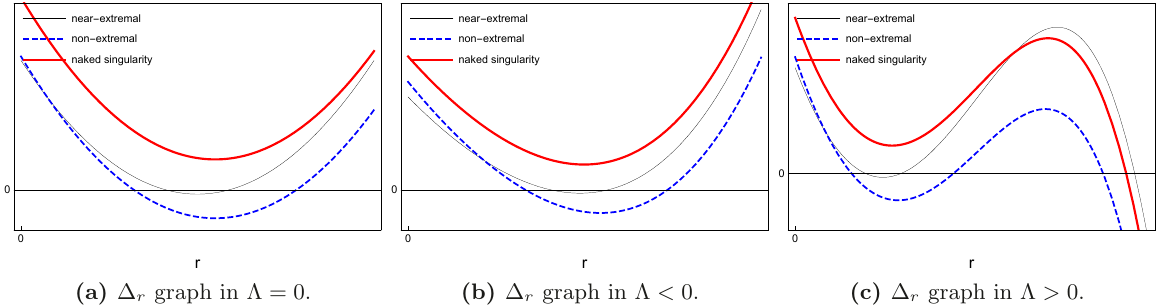
Figure 1. ∆ r graphs for near-extremal, non-extremal, and naked singularity cases for given cosmological